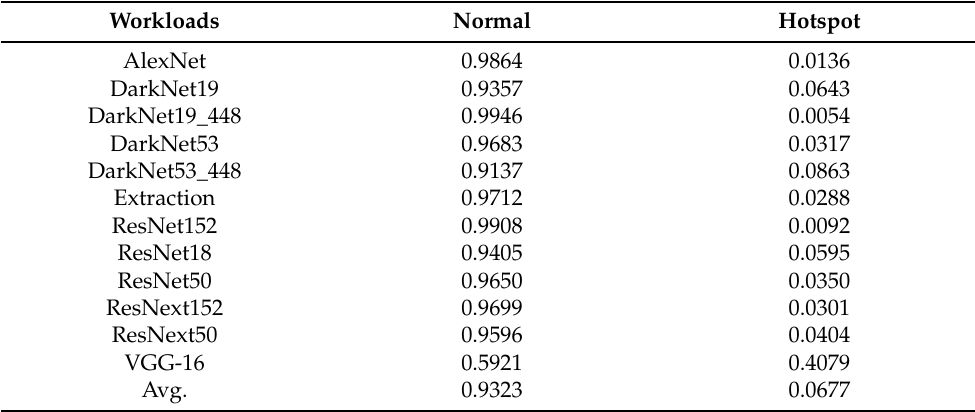
Table 1. Percentage of memory region that covers more than 80% of total